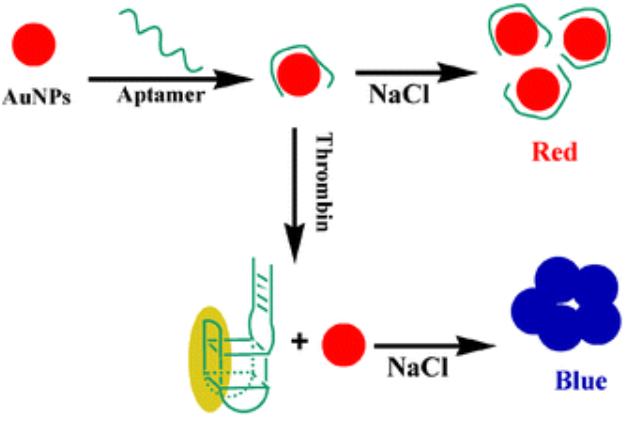
Figure 2. AuNPs colorimetric strategy for thrombin detection